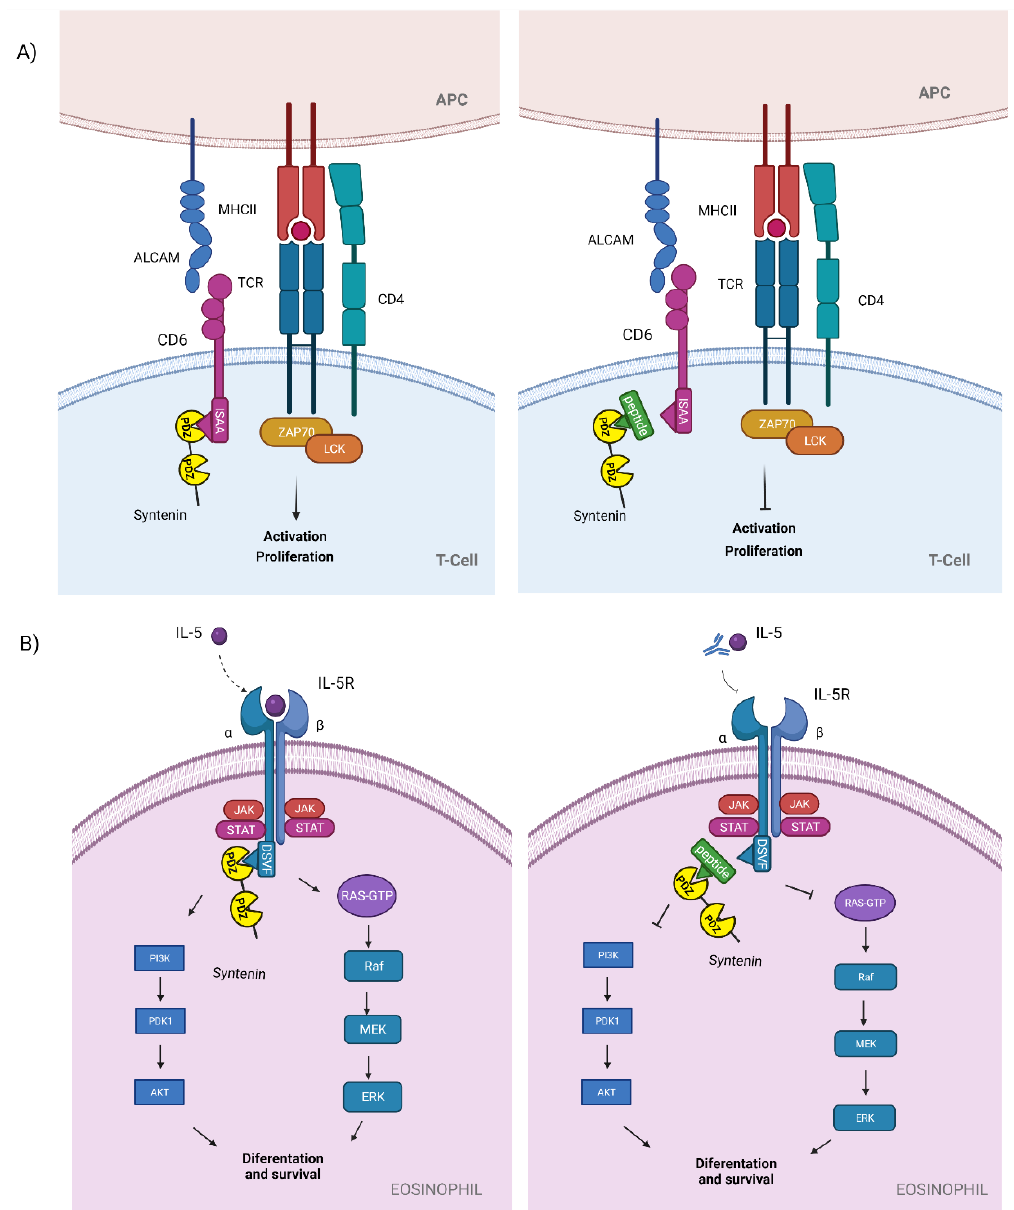
Figure 3. PDZbms associated with syntenin interactions. ( A ) The scavenger receptor cysteine-rich superfamily member CD6 molecule, expressed on T cells, recognizes ALCAM on APCs, stabilizing the immunological synapses, favoring T cell activation and proliferation through a PDZbm (ISAA) binding with a PDZ domain of syntenin (left). Blocking these PDZ- dependent interactions with specific peptides may inhibit Tcell activation and proliferation (right). ( B ) Recognition of the cytokine IL5 by IL-5R induces the interaction between the PDZbm DSVF and syntenin, leading to eosinophil differentiation and survival (left). Eosinophil survival can be blocked by antibodies against IL-5 and possibly by a specific peptide that interferes with the interaction between DSVF and syntenin (right).